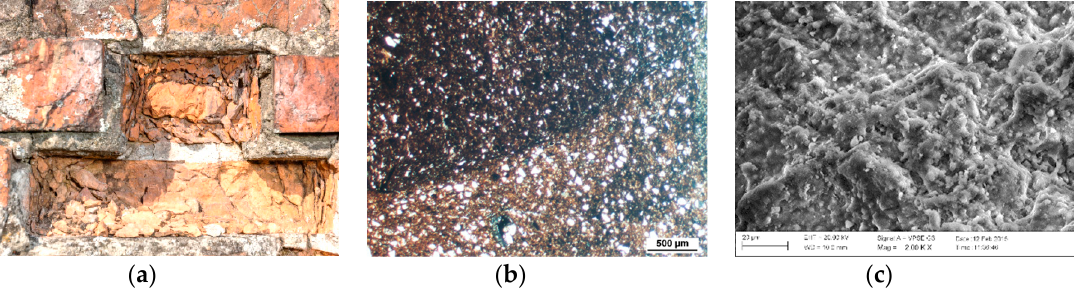
Figure 5. Macroscopic view of damage of the surface of the bricks as a result of cracking ( a ). Optical microscope image. Directional structure of the ceramic mass. Visible are smudges and thin layers containing binding agent with varied fraction of clay substance and iron compounds. Slight directionality of the ceramic mass and a crevice with a pattern matching the component arrangement ( b ). Microstructure of bricks damaged as a result of surface cracking ( c ).